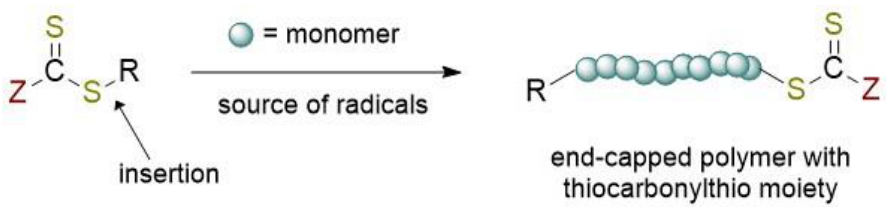
Figure 1. Chemical structure of the RAFT agent and the overall insertion product of the reversible- addition chain transfer polymerization.